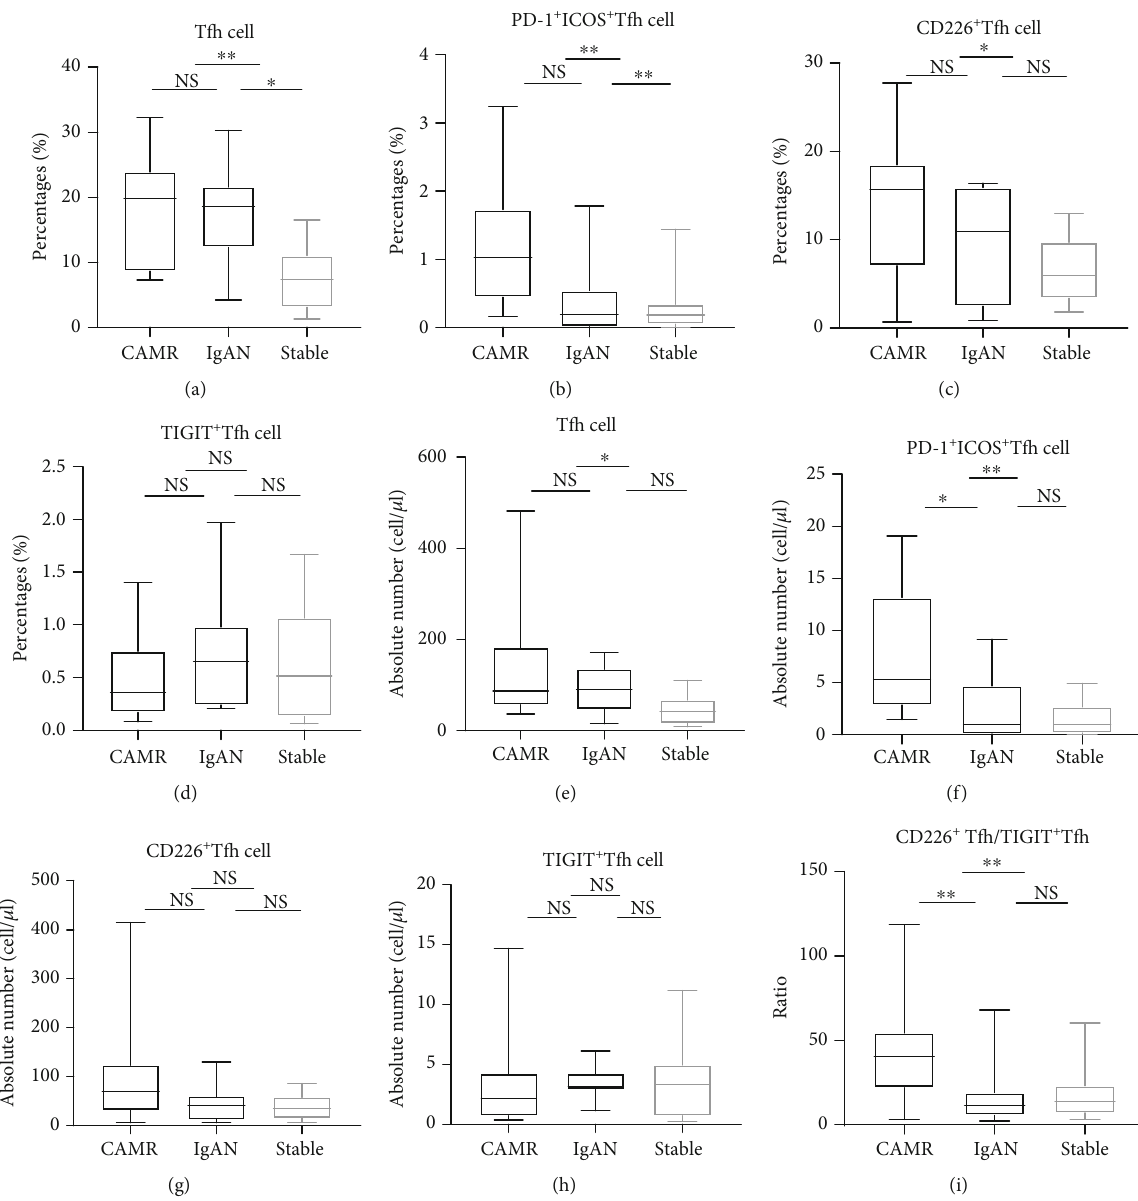
Figure 2: The percentage and absolute number of di ff erent Tfh phenotypes in the CAMR, IgAN, and stable groups. Percentages of (a) Tfh cells, (b) PD-1 + ICOS + Tfh cells, (c) CD226 + Tfh cells, and (d) TIGIT + Tfh cells. Absolute number of (e) Tfh cells, (f) PD-1 + ICOS + Tfh cells, (g) CD226 + Tfh cells, and (h) TIGIT + Tfh cells. (i) The ratio of CD226 + Tfh cells to TIGIT + Tfh